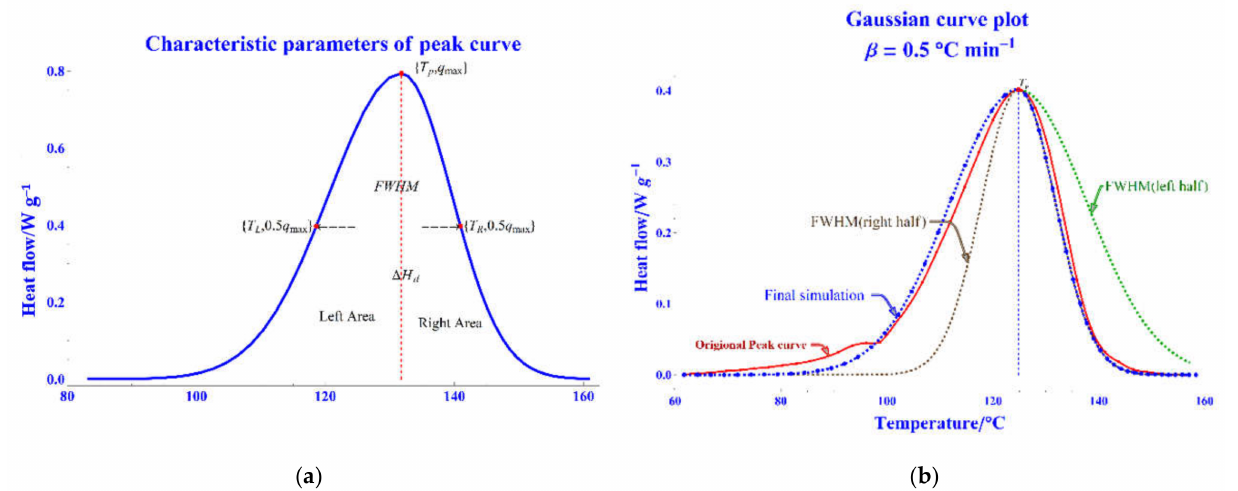
Figure 3. Gaussian curve simulation method. ( a ) Gaussian curve’s simulation parameters; ( b ) Gaus- sian curve